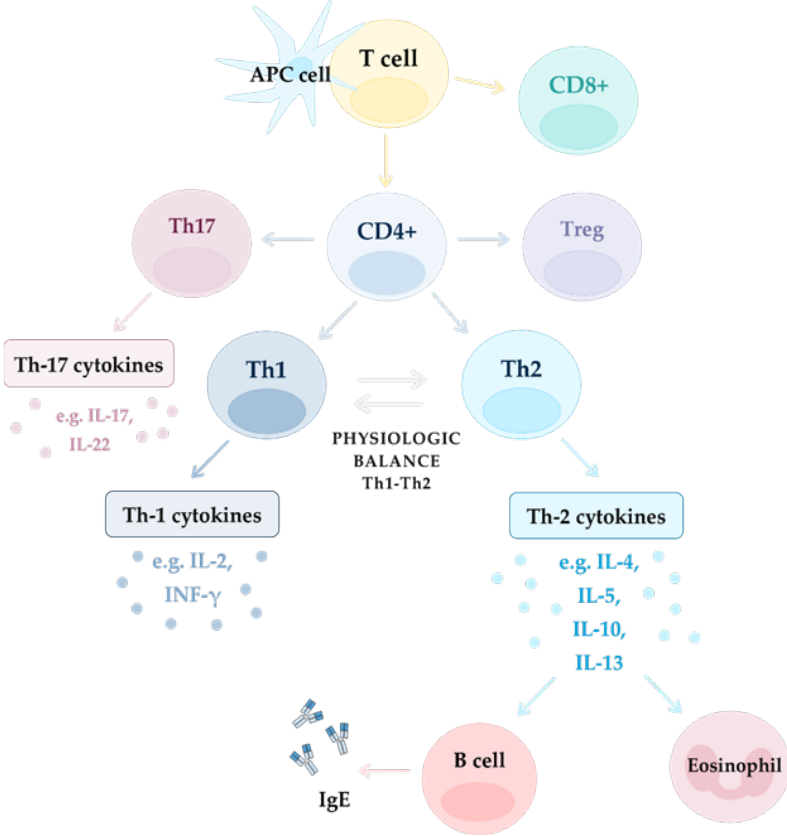
Figure 3. Mechanism of inflammation in different endotypes: Th-2 dependent and non-Th-2 de- pendent (Th1 and Th17 dependent).